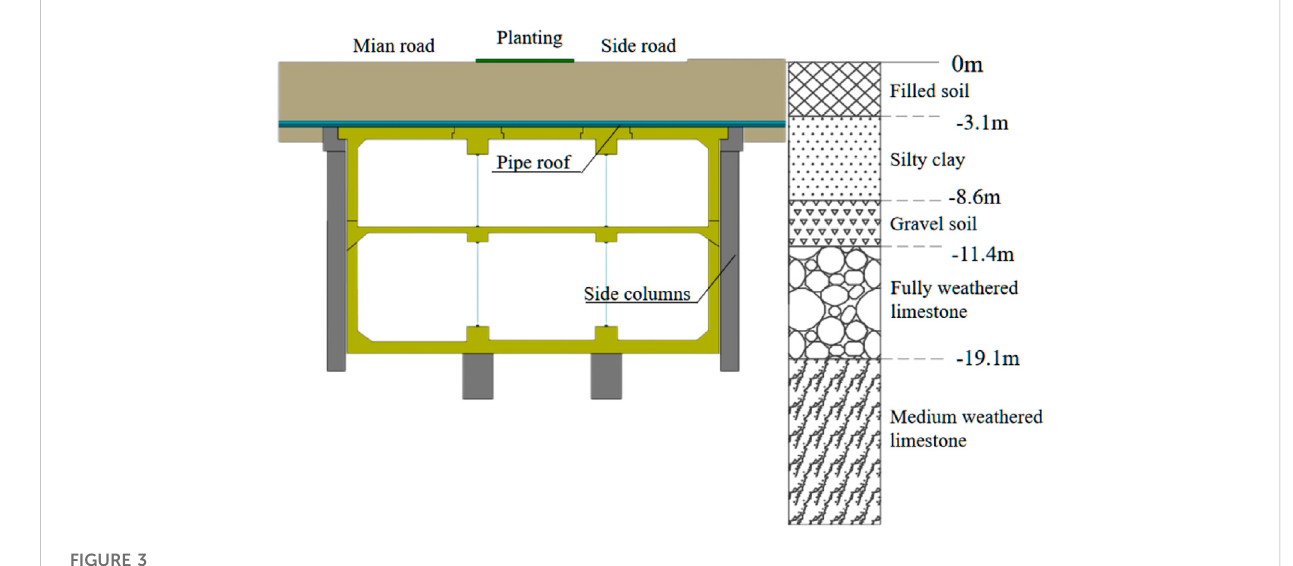
FIGURE 3 Longitudinal pro fi le of the stratum of the station.